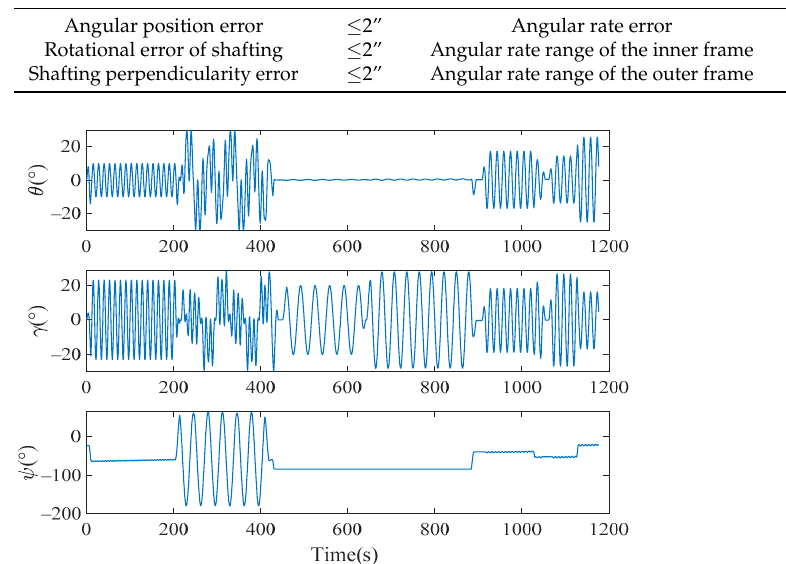
Figure 11. The attitude of the carrier was simulated by the sway of the turntable. The data along the 𝑍 𝑏 -axis of the carrier were obtained through URM 2# and URM 3# by this experimental prototype, and only the information along the 𝑍 𝑏 -axis was redundant. These data along the 𝑋 𝑏 -axis and 𝑌 𝑏 -axis were reused in CSINS1 and CSINS2. Therefore, by further analyzing the error term 𝛿𝑓 𝑧3𝑏 of Equation (19), it can be concluded that installation errors 𝛥𝜇 𝑥3 and 𝛥𝜇 𝑦3 are fully observable, while 𝛥𝜇 𝑧3 is unobservable. The experimental results of the installation error for URM 3# are shown in Figure 12. 𝛥𝜇 𝑥3 and 𝛥𝜇 𝑦3 tend to be stable over time, while 𝛥𝜇 𝑧3 cannot be estimated. The covariance curve of the installation error is shown in Figure 13, which also proves that 𝛥𝜇 𝑧3 is unobservable, and 𝛥𝜇 𝑥3 and 𝛥𝜇 𝑦3 are gradually converging over time. The mean value of the installation error was calculated after 800 s, and the mean values of 𝛥𝜇 𝑥3 and 𝛥𝜇 𝑦3 were − 544.72” and − 871.52”, respectively. Therefore, the experimental results agree with the theoretical analysis, which proves the effectiveness of the proposed self-calibration method.